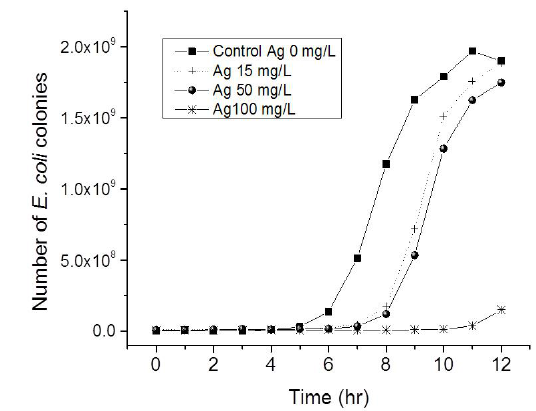
Fig. 8. Growth curves in TSA agar inoculated with of E.Coli ATCC 25992 bacteria in the presence of different concentrations of AgNPs <10nm synthesized.